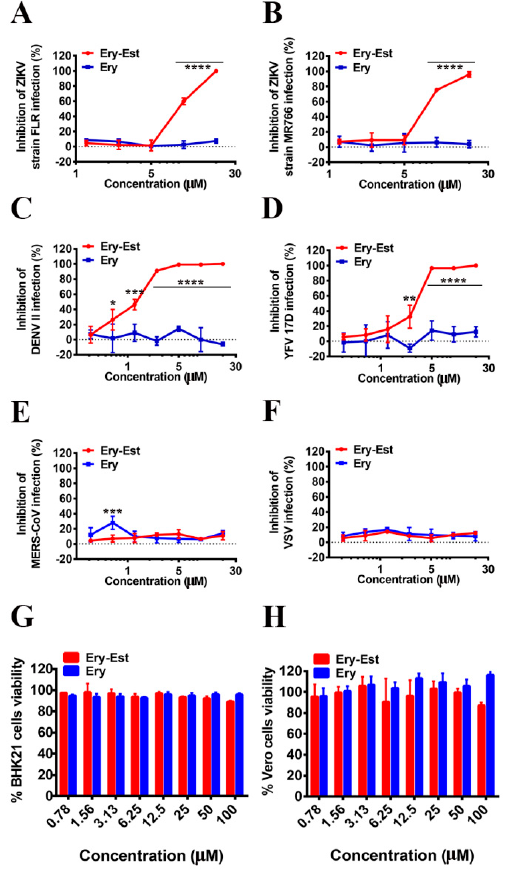
Figure 2. Inhibition of Ery-Est against flavivirus infection with a broad spectrum and its cytotoxicity. BHK21 cells (2 × 10 6 ) were infected by ZIKV strains ( A ) FLR, ( B ) MR766, ( C ) DENV II, and ( D ) YFV 17D with the treatment of serial concentrations of Ery-Est and Ery, and then covered with Dulbecco’s modified Eagle’s medium (DMEM) containing 2% FBS and 1% LMP agarose. After incubation for about 5 days, infected cells were stained with 1% crystal violet for plaque visualization and the inhibitions of infection were calculated. Huh7 cells (2 × 10 4 ) were infected by ( E ) pseudotyped MERS-CoV and ( F ) VSV with the treatment of Ery-Est and Ery, the inhibitory activity was measured by the luciferase assay systems after incubation for 3 days. ( G ) BHK21 and ( H ) Vero cells (2 × 10 4 ) were treated with Ery-Est and Ery for 72 h, and the cell counting kit-8 (CCK8) was used to detect cell viability. The experiments were tested in triplicate and data are represented as means ± SD. Each experiment was repeated at least twice and similar results were obtained. Statistical analysis: Two-way ANOVA with Sidak’s multiple comparisons for ( A – F ). * p < 0.05; ** p < 0.01; *** p < 0.001; **** p < 0.0001. Following this, we also researched whether Ery-Est was able to inhibit other mosquito-borne